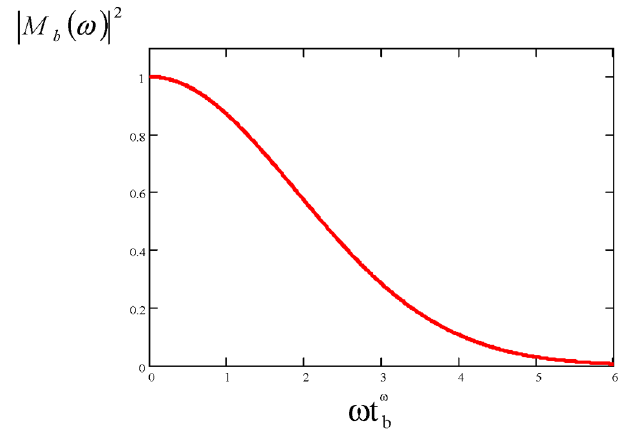
(cid:4) ! (cid:5)j 2 (cid:1) b (cid:5) (cid:1) 0